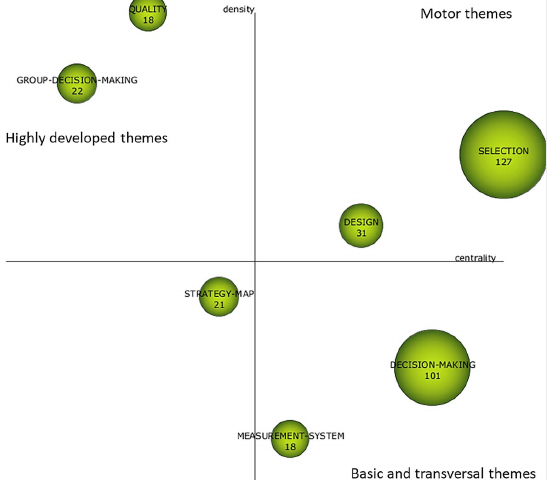
Figure 1. Strategic diagram of the use BSC – AHP in literature